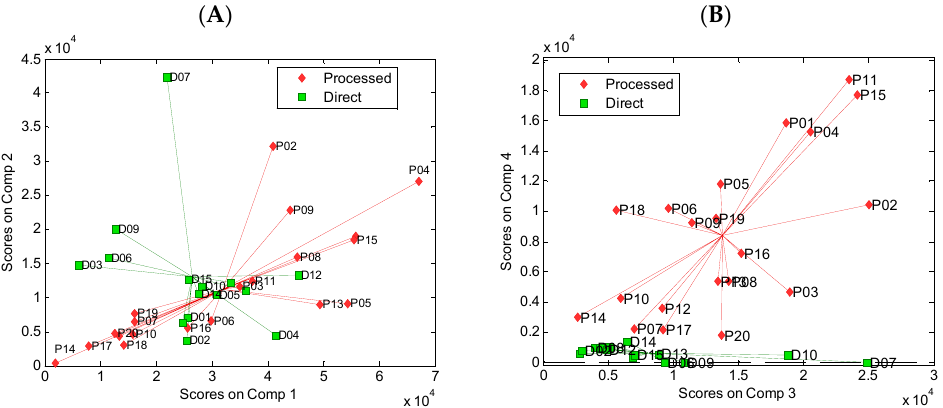
Figure 4. The results of PARAFAC of EEMs of direct fresh and processed commercial strawberry beverages: ( A ) scores for component 1 vs. component 2, ( B ) scores for component 3 vs. component 4.